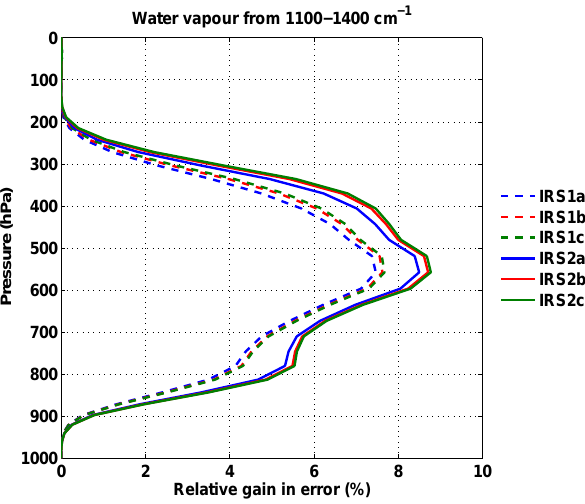
Figure 7. Impact of spectral resolution and radiometric noise on the retrieval of water vapour profile based on the use of the 1100– 1400cm − 1 spectral band. The relative gain in error is defined as the difference between the a priori and a posteriori error, divided by the a priori error, averaged over the whole tropical TIGR